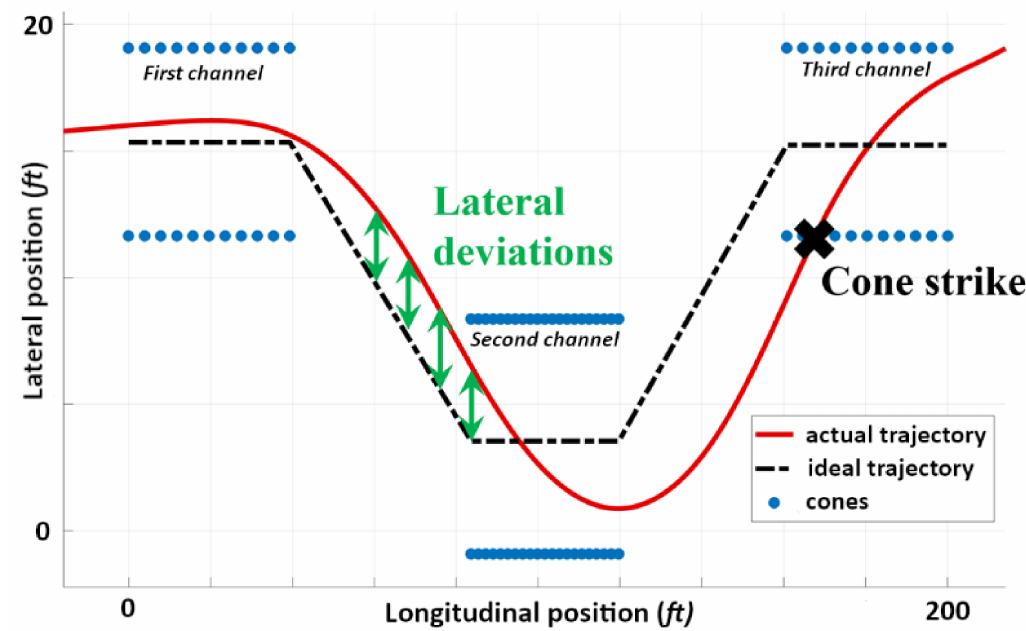
Figure 19. Lateral deviations as a metric for quantifying Moose Test